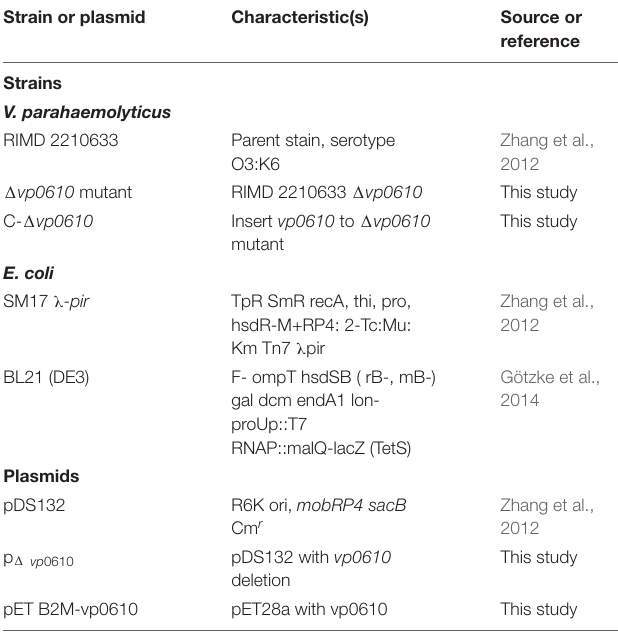
TABLE 1 | Bacterial strains and plasmids used in this